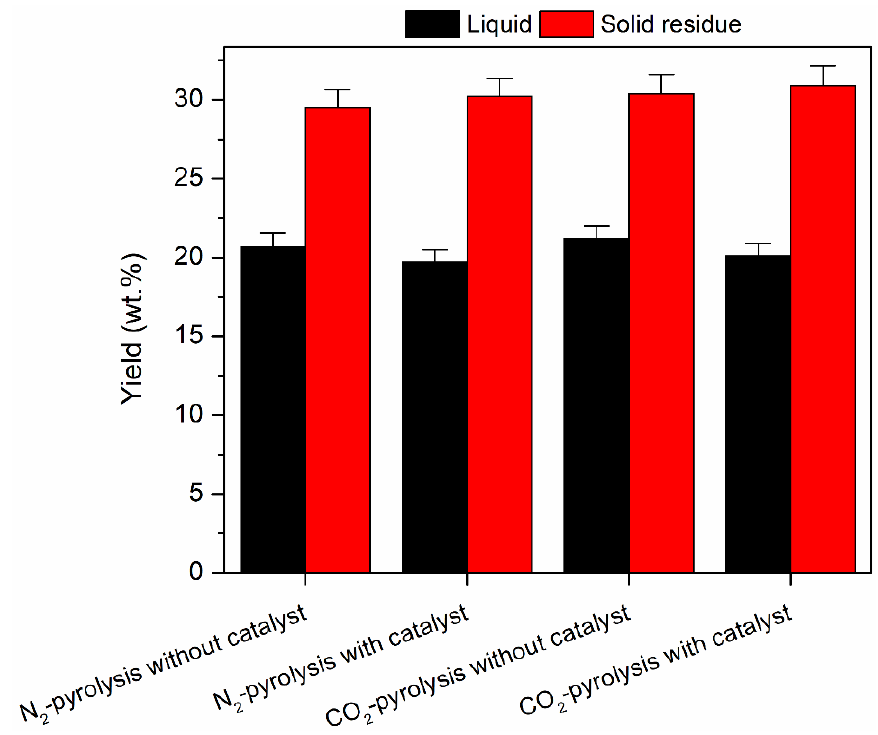
Figure 2. Liquid and residual solid yields obtained from four different pyrolysis experiments. Mean values of replicates (n = 3) are reported with standard deviations given as error bars.